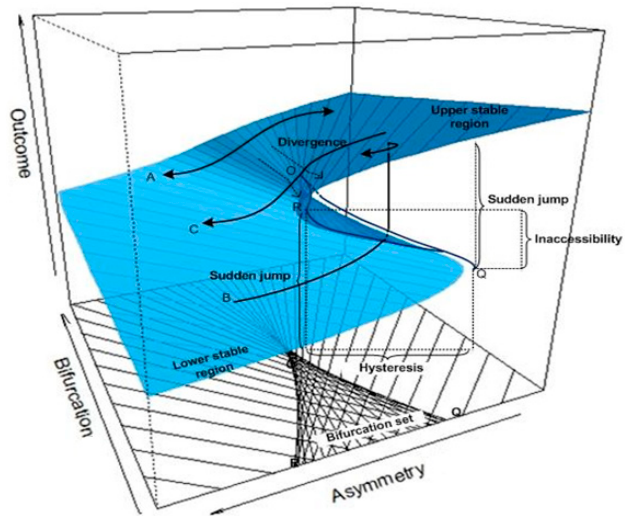
Figure 1. Cusp catastrophe model showing continuous and discrete changes in outcome ( Y ) on the equilibrium plane as the asymmetry variable α and the bifurcation variable β changes.